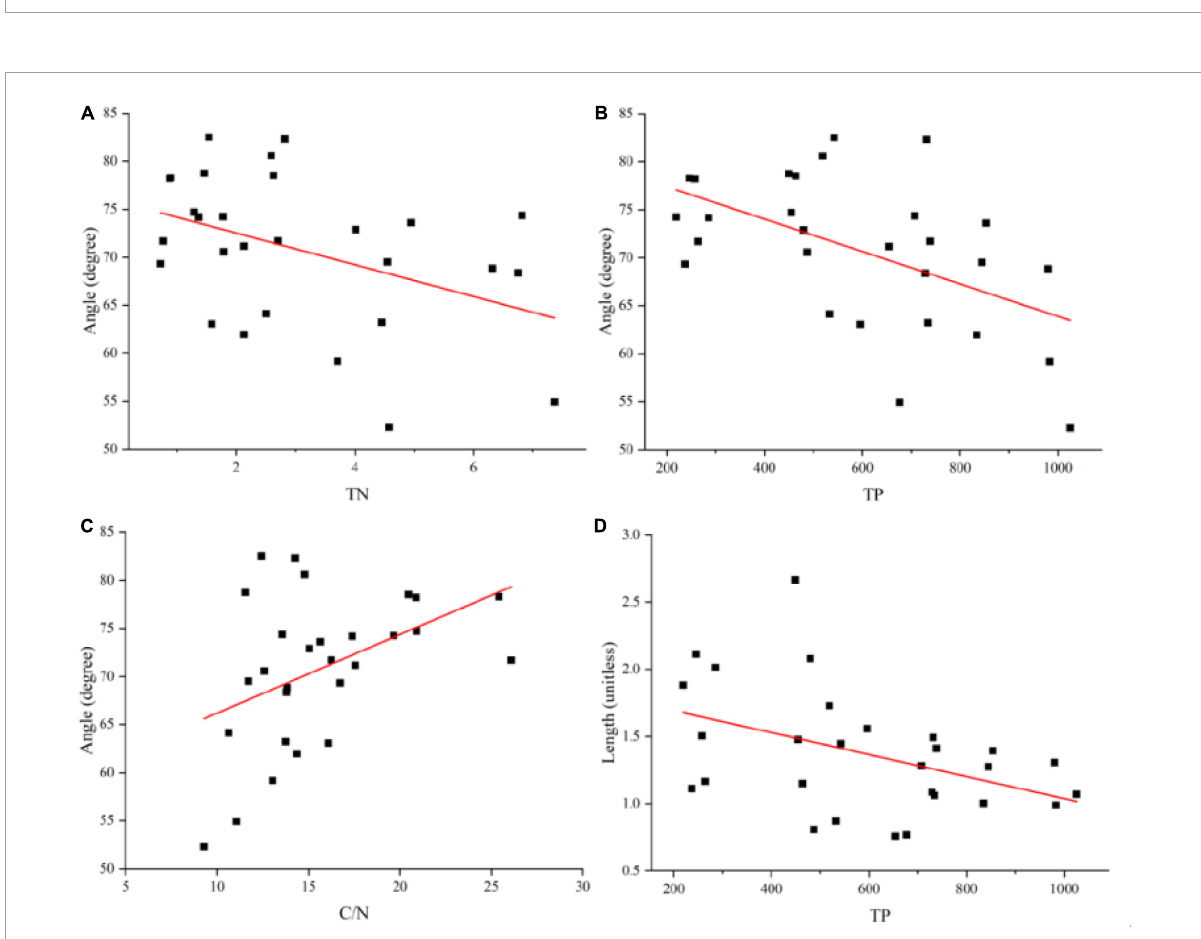
FIGURE3 Relationships between vector angle and soil total N or soil total P or soil C: N (A–C) , and between vector length and total P (D) . All P -values of the regression analysis were <